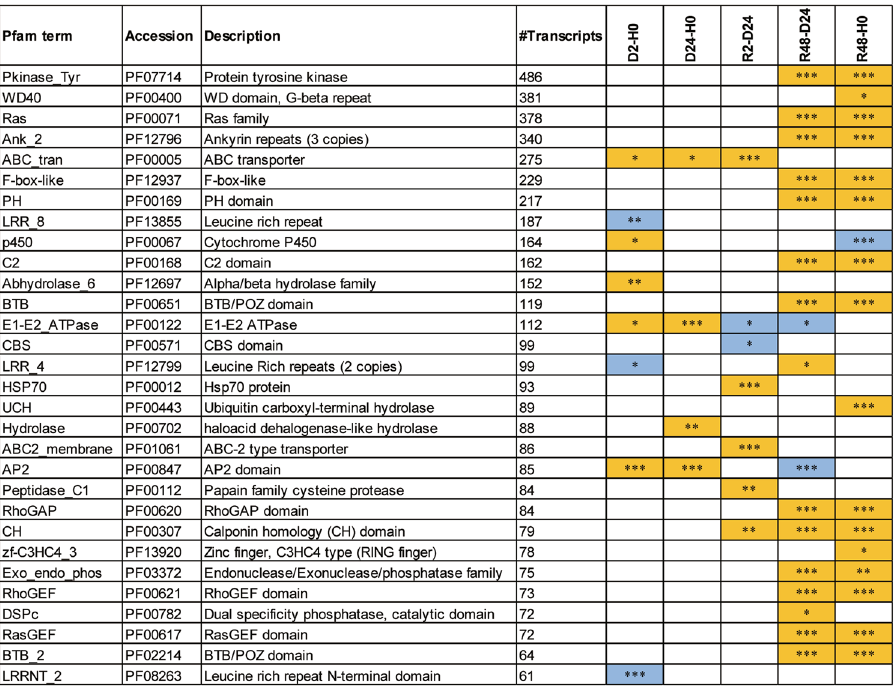
Figure 5. Protein family (Pfam) terms enriched for up- and down-regulated transcripts, upon dehydration, desiccation and rehydration. The yellow color indicates enriched up-regulated and blue down-regulated Pfam terms. Significance levels are marked by asterisks in the boxes ( *** FDR ≤ 0.001; ** 0.001 < FDR ≤ 0.01; * 0.01 < FDR ≤ 0.05). The p-values were FDR corrected and cut-off was set at FDR ≤ 0.05.